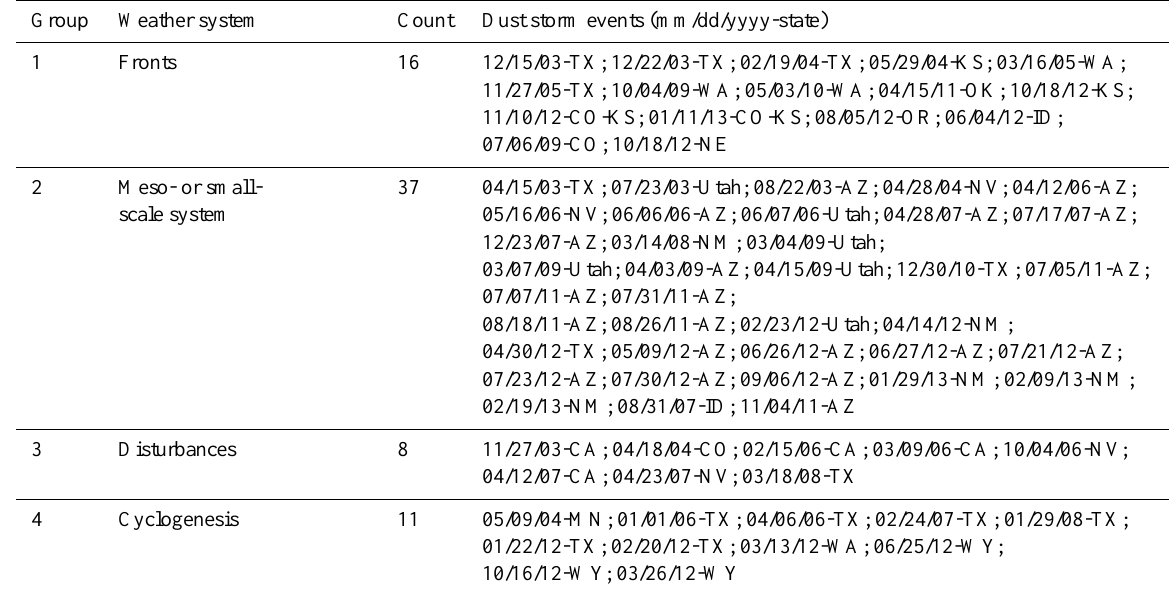
Table 1. Classification of reported dust storm events over the western US.